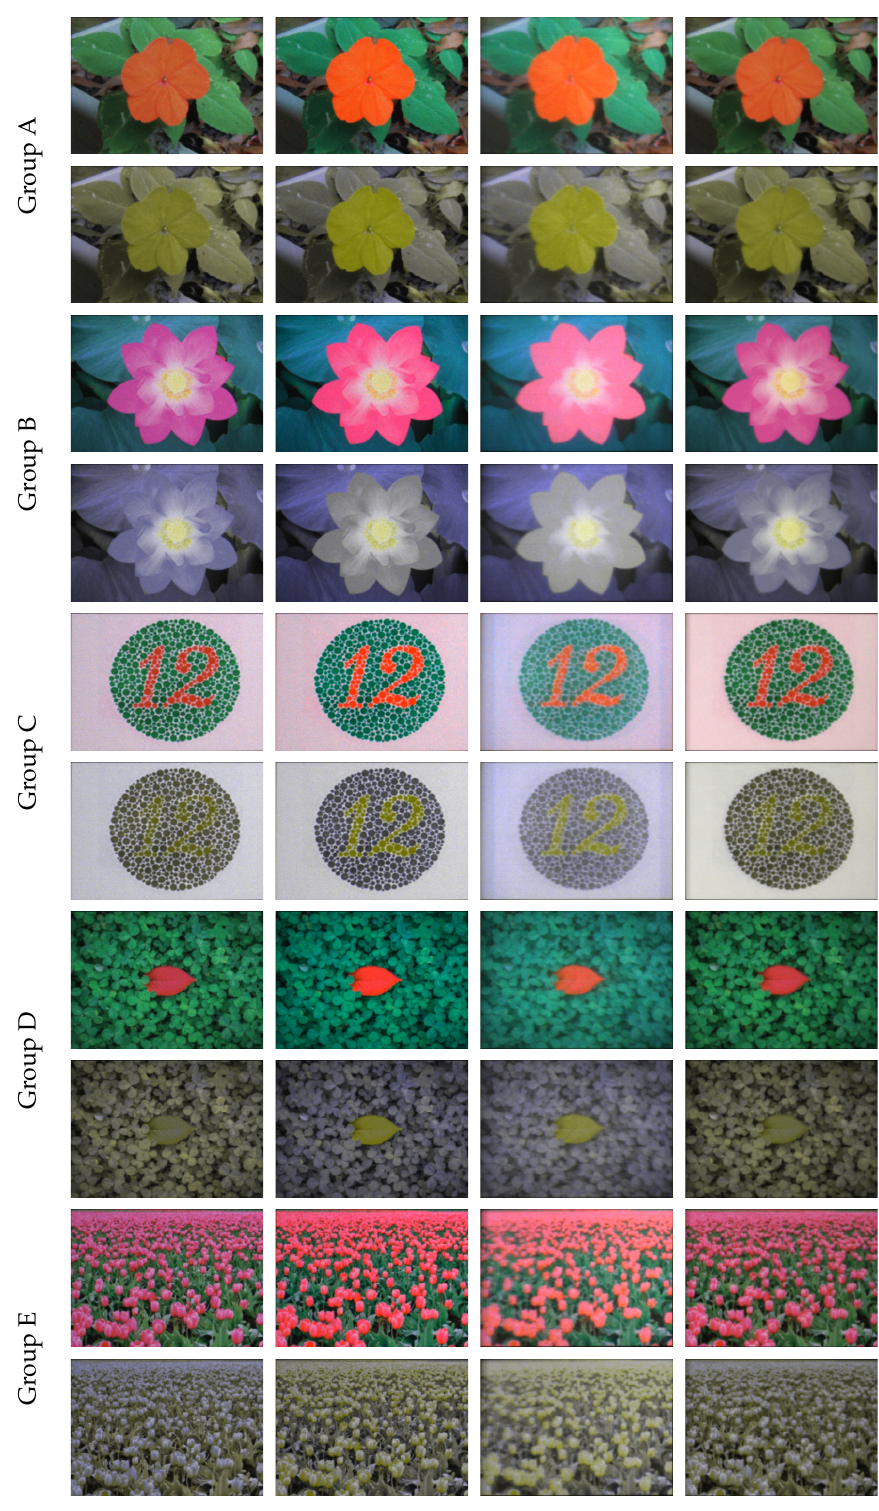
Figure 10. Pictures in odd rows from left to right are: images captured by the scene camera, I S ; the ideal compensation results, I T , by applying the Daltonization process to I S ; the result using our proposed method; and the result using the existing method [13]; pictures in even rows are from the deuteranopia simulation following the same order of methods as given